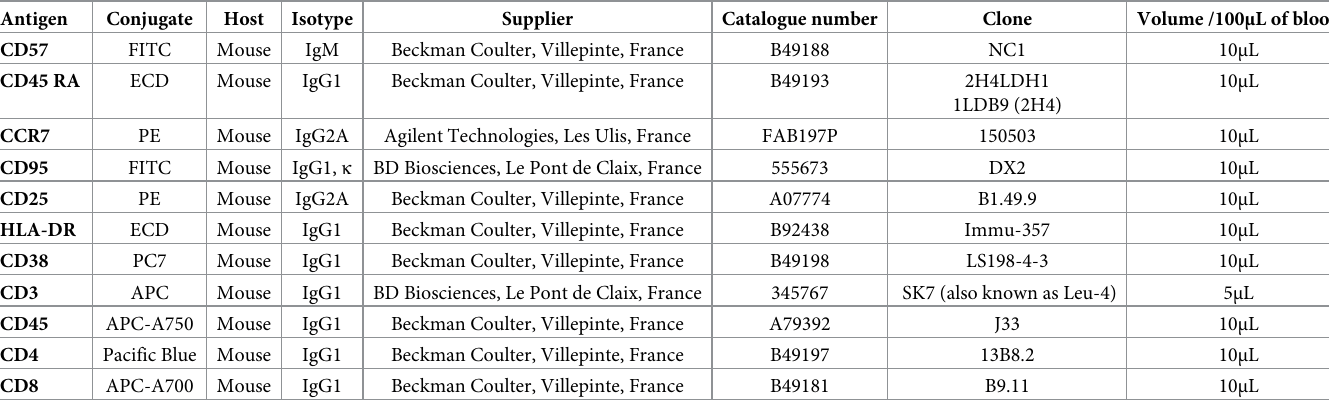
Table 1. Primary antibodies used for T cell detailed phenotype.